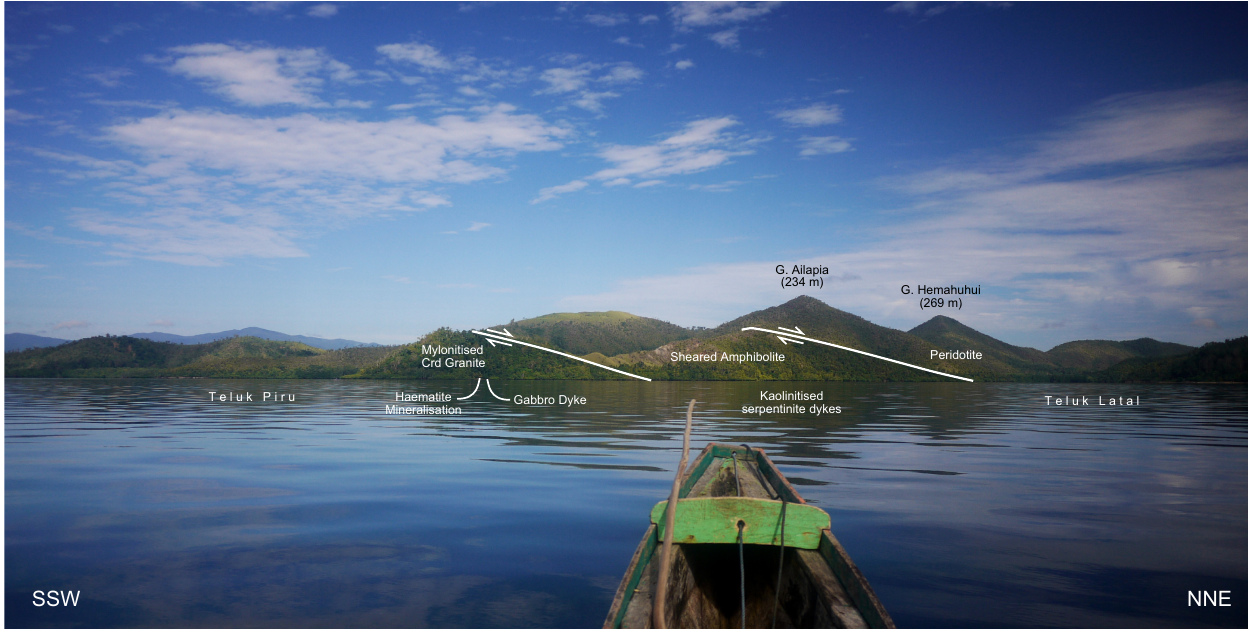
Fig. 8. Tanjung Motianai and the South Kaibobo Shear Zone, viewed from the SE. Mylonitised granites are overlain by sheared amphibolites. The contact between the amphibolites and peridotites is intensely serpentinised and numerous serpentinite dykes and associated kaolinites are present. The granite mylonite is intruded by a gabbro dyke and several haematite